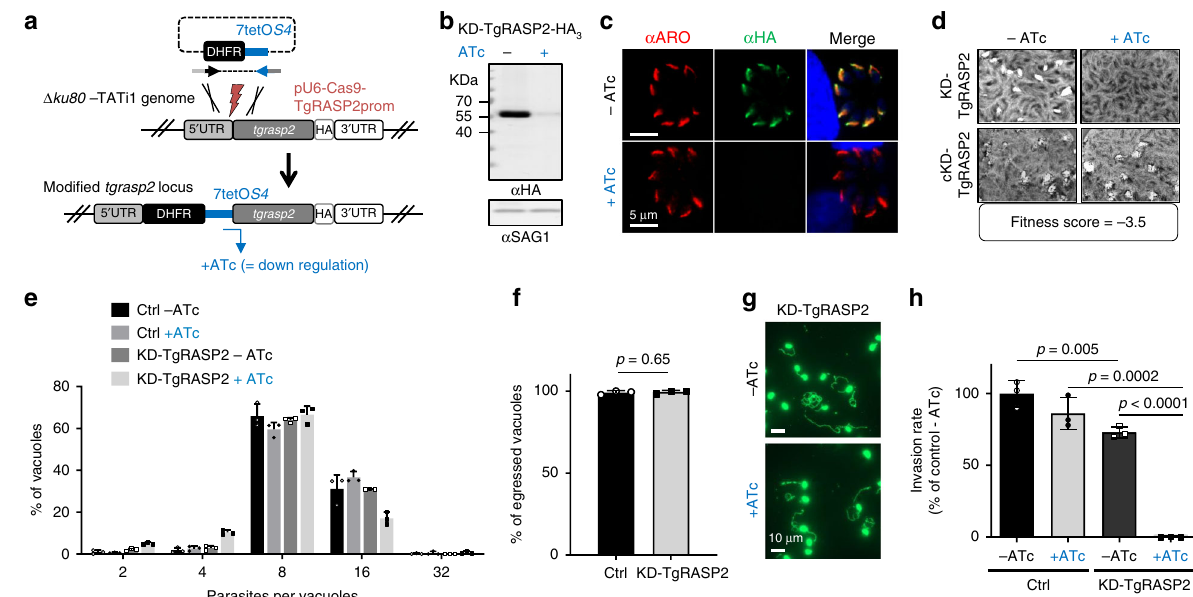
Fig. 4 Toxoplasma RASP2 depletion impairs parasite invasion. a Strategy for conditional depletion of TgRASP2 using the Tet-OFF system. b Immunoblot of KD-TgRASP2-HA 3 (±ATc). SAG1, loading control. c IFA of KD-TgRASP2-HA 3 shows depletion of RASP2 after 2 days ATc treatment. d Plaque assays of KD-TgRASP2 and complemented cKD-TgRASP2 parasites (±ATc) shows that the strong phenotype induced by TgRASP2 depletion (no plaques) can be rescued by a complementing copy of the gene. CRISPR fi tness score was derived from Ref. 20 . e Intracellular replication of TATi_TgRASP2-HA 3 (Ctrl) and KD-TgRASP2-HA 3 ± 48 h ATc. The percentage of vacuoles containing 2, 4, 8, 16 or 32 parasites was determined on 200 vacuoles ( n = 3). f Percentage of egressed vacuoles in TATi_TgRASP2-HA 3 (Ctrl) and KD-TgRASP2-HA 3 + ATc. Parasite egress was induced 30 h post-invasion by addition of A23187 (3 μ M) for 8 min before samples were fi xed and processed for IFA (anti-GRA3 antibodies). Egress events (GRA3 in the PV) were quanti fi ed on 30 vacuoles. g Gliding assays were performed with KD-TgRASP2 ± ATc 48 h. Trails were revealed by IFA using anti-SAG1 antibodies. h 5 min-invasion assay of TATi_TgRASP2-HA 3 (Ctrl) and KD-TgRASP2-HA 3 parasites (±ATc) shows a strong invasion defect when TgRASP2 is affected. (d, e, f, h) Values represent means± SD, n = 3, from a representative experiment out of 2 independent assays. Source data are provided as a Source Data fi